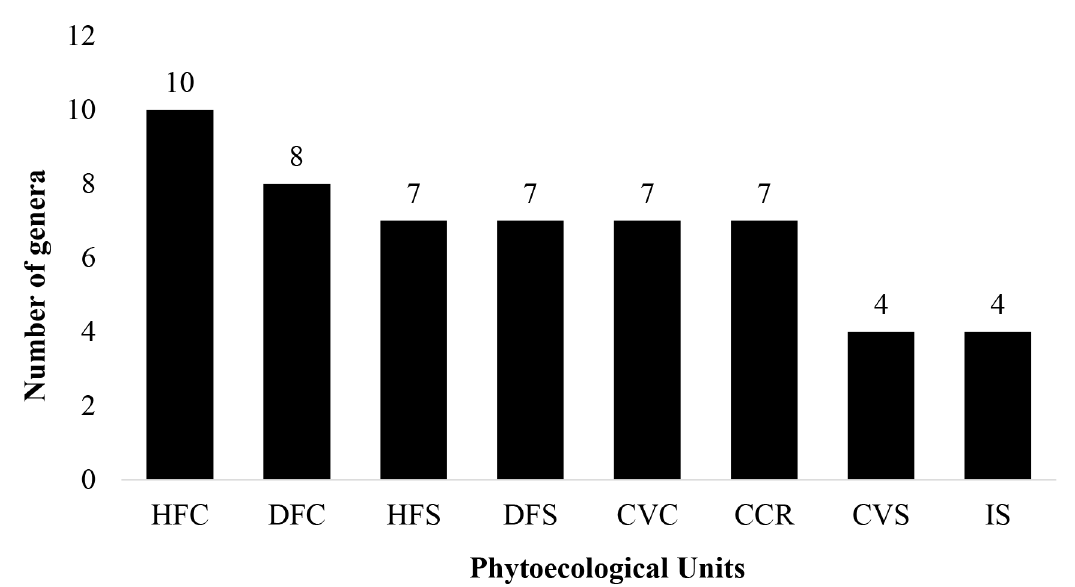
Figure 3. Representation of the abundance of meliponine genera in eight phytoecological units of the State of Ceará in 2013 and 2014. Phytoecological Units: HFC - Humid forest of the Crystalline Landscapes; DFC - Dry Forest of the Crystalline Landscapes; HFS - Humid Forest of the Sedimentary Landscapes; DFS- Dry Forest of the Sedimentary Landscapes; CCR- Caatinga Vegetation on Crystalline Relief; CVC - Coastal Vegetation Complex; CVS - Caatinga Vegetation on Sedimentary Relief; IS – Inland